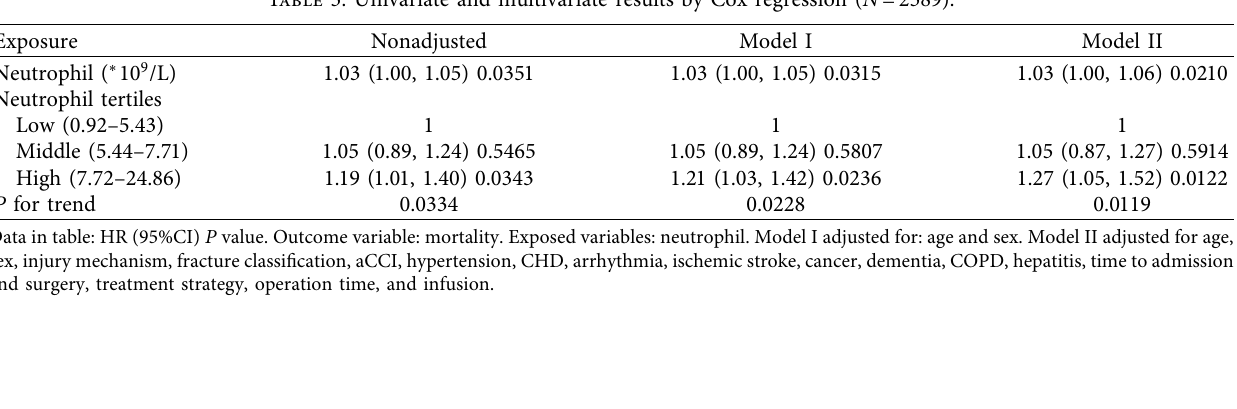
Table 3: Univariate and multivariate results by Cox regression ( N � 2589).